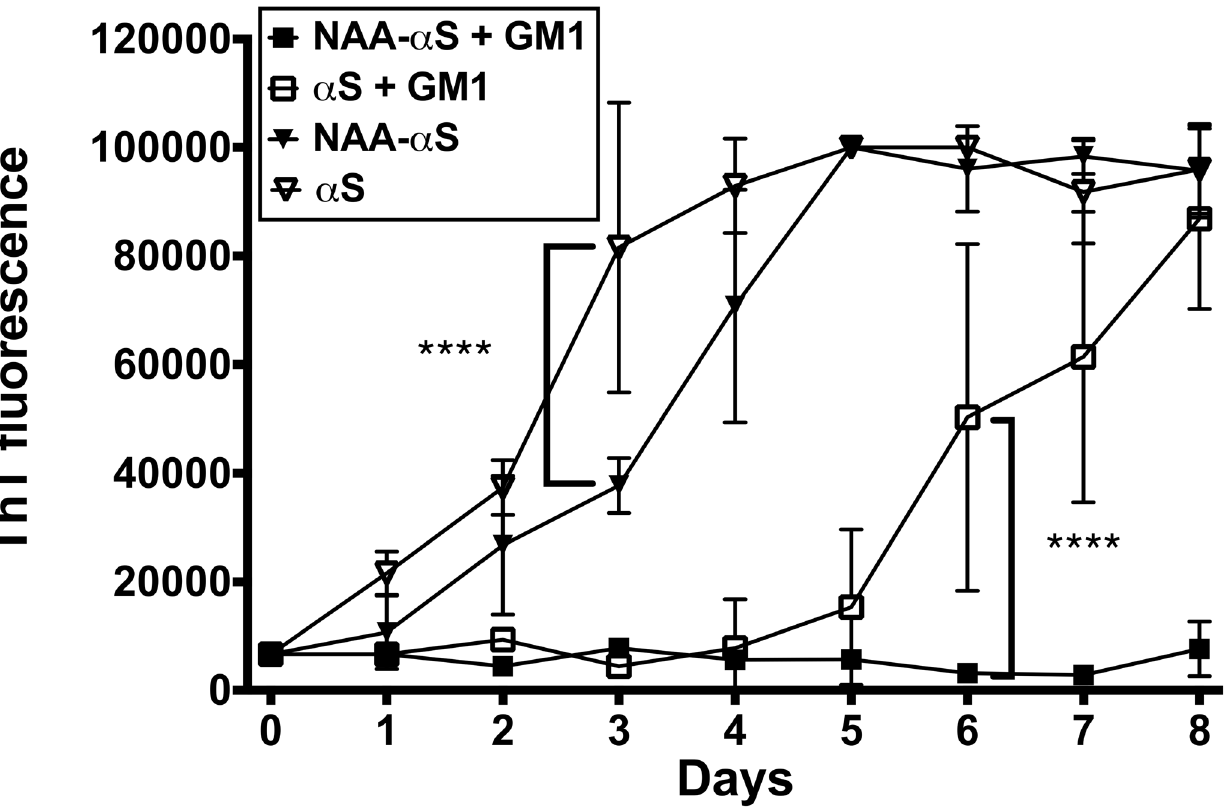
Figure 5. N-alpha acetylation has a functional impact on a S aggregation into amyloid fibrils. Aggregation of NAA- a S and a S (0.6 mg/ml) in the absence or presence of GM1 containing vesicles (GM1/protein 10:1 mol/mol) measured by an increase in thioflavin T fluorescence. Standard deviations are calculated from N=4 experiments. The presence of N-acetylation or GM1 vesicles binding each led to increased resistance to aggregation, with the effects being cumulative. A 2-way ANOVA test was used to test for significance at selected time points. ****=p ,